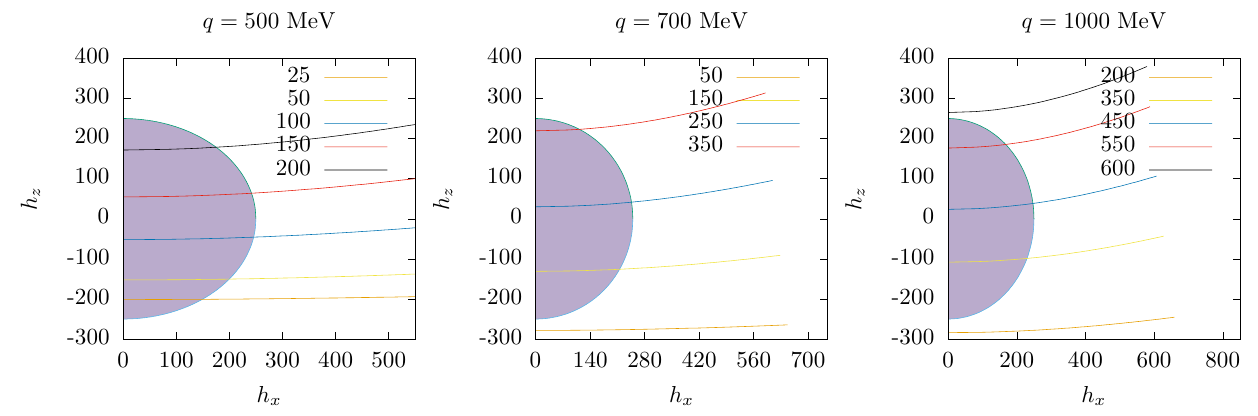
Figure 1. Integration path in momentum space of the initial nucleon corresponding to the integral (13) for different values of the energy transfer ω (indicated in MeV in the key for each panel) and for three values of the momentum